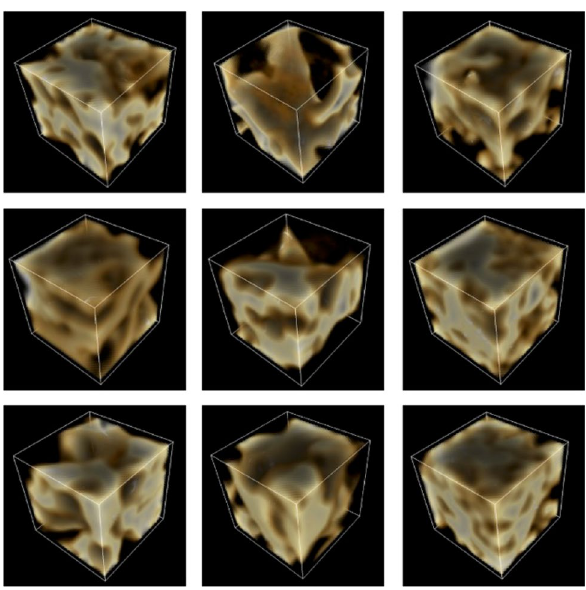
Fig. 10 Examples of class 3 subblocks